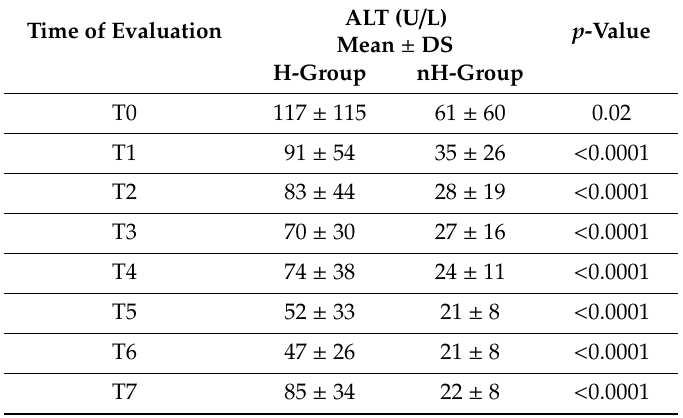
Table 2. ALT levels in 48 HFI patients distinguished in HFI patients with (H-group) and without (nH-group) persistent hypertransaminasemia, from diagnosis to the end of follow-up. Time of